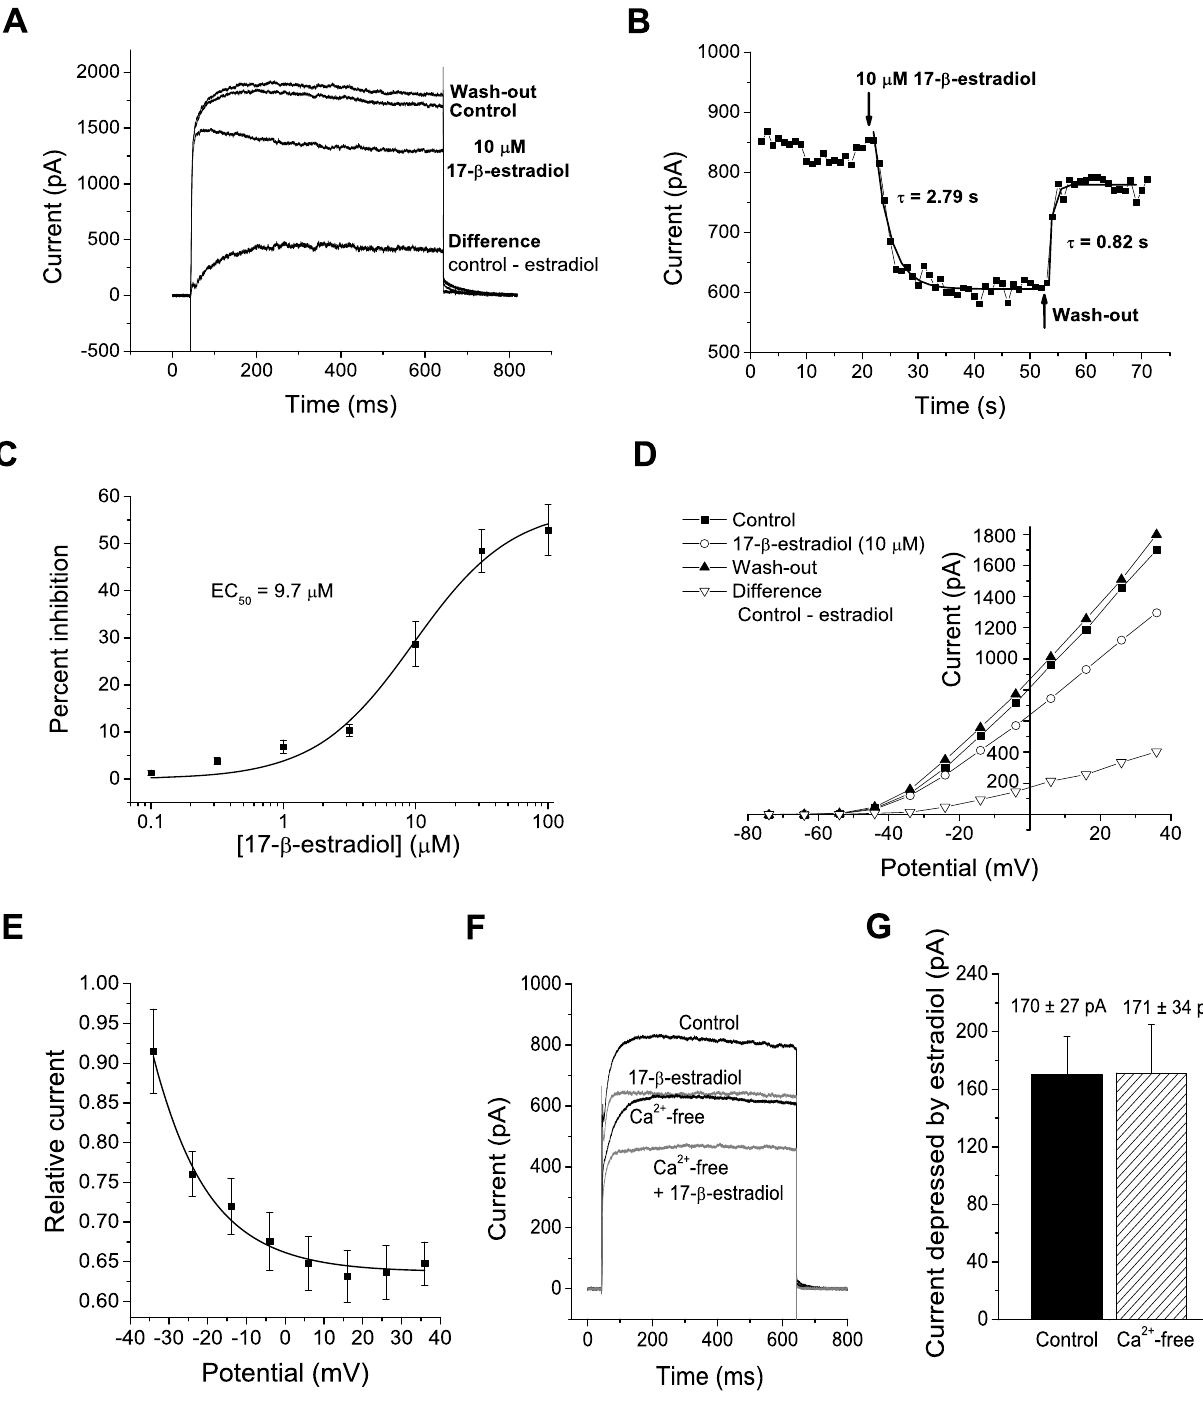
Figure 1. 17- b -estradiol rapidly reduces K + currents in MPN neurons. A, K + currents evoked by a voltage step from 2 74 mV to + 36 mV, in control solution, after the addition of 10 m M 17- b -estradiol and after wash-out of 17- b -estradiol, as indicated. B, time course of estradiol-induced depression, from the neuron in A. Mean current 190–200 ms after voltage steps to + 26 mV from 2 74 mV. (No leak current subtraction.) 17- b - estradiol was applied as indicated. Superimposed lines show fitted exponentials. C, concentration-response relation for 17- b -estradiol-induced depression of K + currents. Mean currents 590–600 ms after a voltage step to + 26 mV from 2 74 mV. Smooth line is described by Equation 1 with EC 50 =9.7 m M, n=1.2, Inh max =58%. Data from 7 neurons. D, I–V relations for mean current 590–600 ms after a voltage step from 2 74 mV to the potentials indicated, for one MPN neuron. Current in solutions as indicated. E, relation between the effect of 10 m M 17- b -estradiol (ratio of current in estradiol to that in control solution; mean current 590–600 ms after voltage step from 2 74 mV) and membrane voltage for 12–13 neurons. Mean 6 S.E.M. The superimposed line is an exponential function, with e -fold change per 14 mV, fitted to the data. F–G, Ca 2 + independence of estradiol-sensitive current. F, currents evoked by a voltage step from 2 74 mV to + 6 mV, with extracellular solution modified as indicated. Note that estradiol (10 m M) induced a similar depression in the presence and absence of Ca 2 + . G, current depressed (mean current 590–600 ms after a voltage step to + 6 mV) by 10 m M 17- b -estradiol added to standard extracellular solution (left bar) and to a solution with Co 2 + substituted for Ca 2 + (right bar). The same 9 neurons were used for both conditions. The difference was not significant.